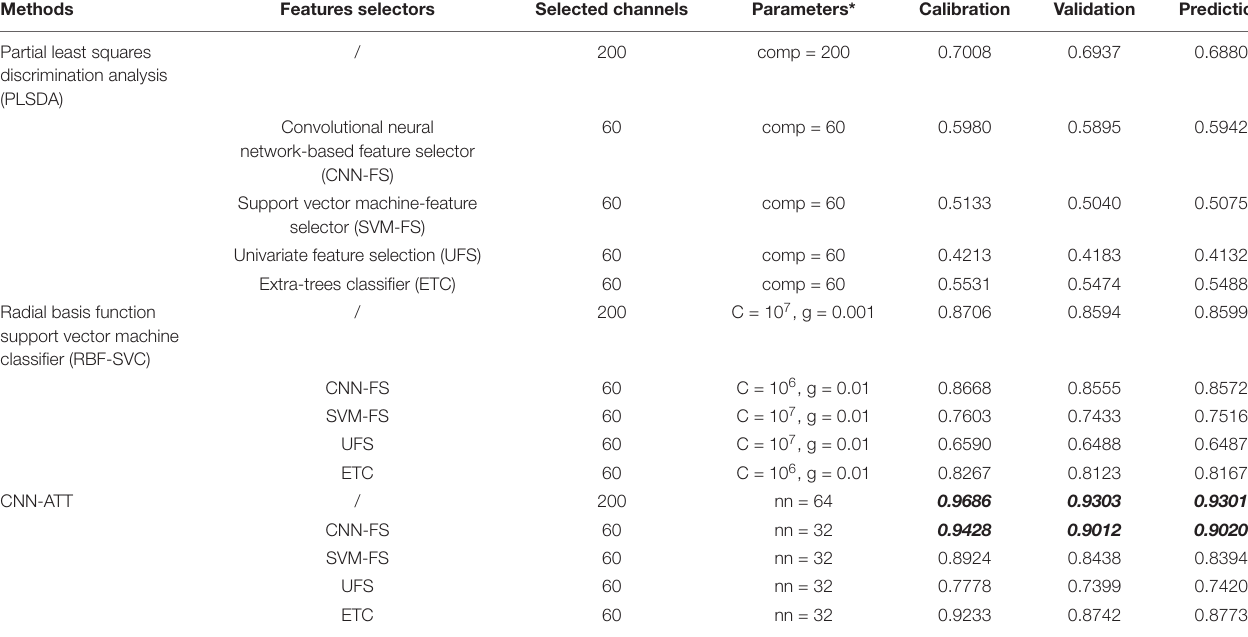
TABLE 2 | The classification accuracies achieved by different feature selectors and classifiers.